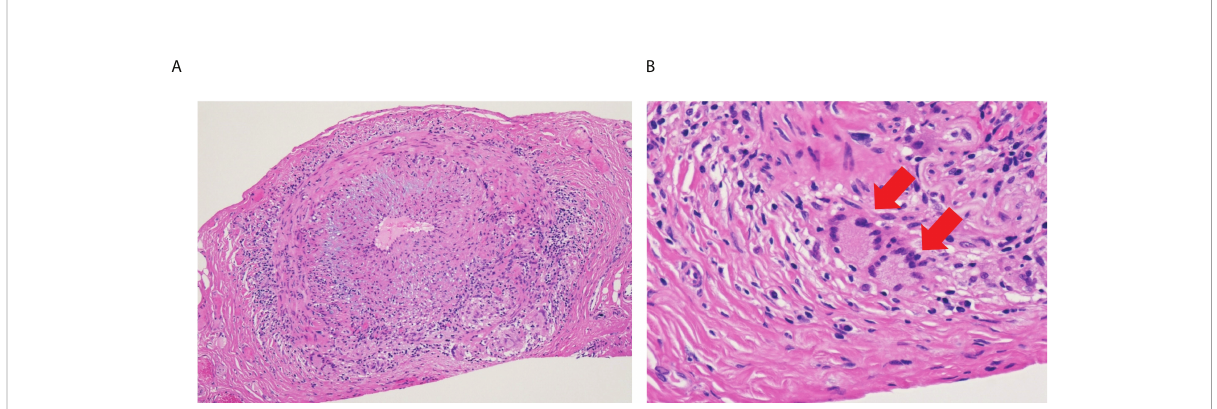
FIGURE 1 Microscopic image of giant cell arteritis. (A) Left temporal artery biopsy from 65-year-old woman with giant cell arteritis (Hematoxylin and eosin staining, x10). Lymphocytes and macrophages form granulomatous in fl ammation, and intimal hyperplasia causes narrowing of the blood lumen. (B) High power fi eld image of the biopsy (Hematoxylin and eosin staining, x40). Red arrows show multinucleated giant